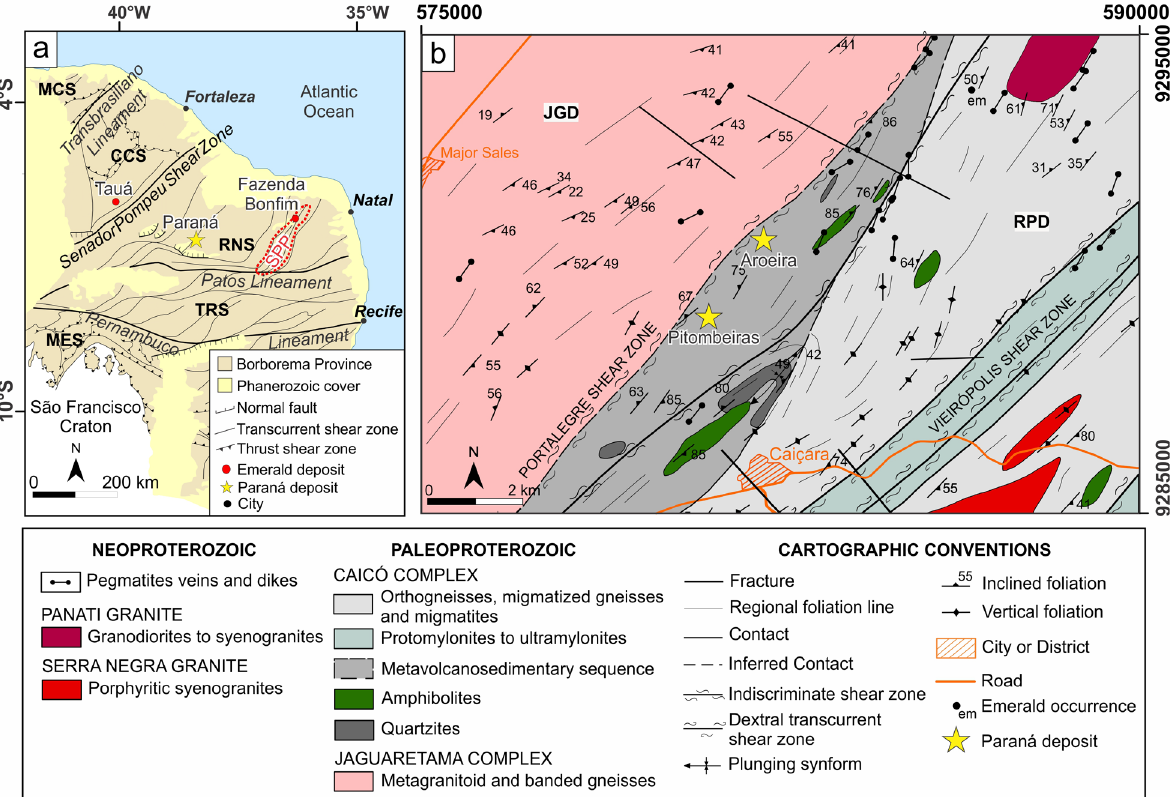
Figure 1. Geological setting of the Paraná deposit. (a) Tectonic subdivision of Borborema Province with the main emerald deposits (Tauá, Paraná and Fazenda Bonfim). Modified from Santos et al. (2014). (b) Local geological map of the Paraná region showing the main emerald mines: Pitombeiras and Aroeira. Modified from Araújo Neto et al. (2018). MCS: Médio Coreaú Sub-province; CCS: Ceará Central Sub-province; RNS: Rio Grande do Norte Sub-province; TRS: Transversal Sub-province; MES: Meridional Sub-province; SPP: Seridó Pegmatite Province; JGD: Jaguaribeano Domain; RPD: Rio Piranhas-Seridó